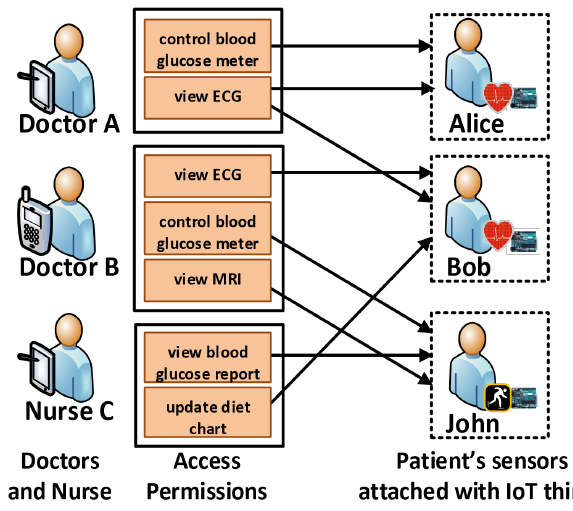
Figure 1. A fine-gained access controlscenario for di˙erent actors in a healthcare system. Where a doctor/nursewith an appropriatepermission can only view/controla subset of a patient’s IoT-enabled healthcare ‘things’. For instance, a specialist Doctor A (e.g. cardiologist) can view a particular patient’s (e.g. Bob) heart sensorrelated